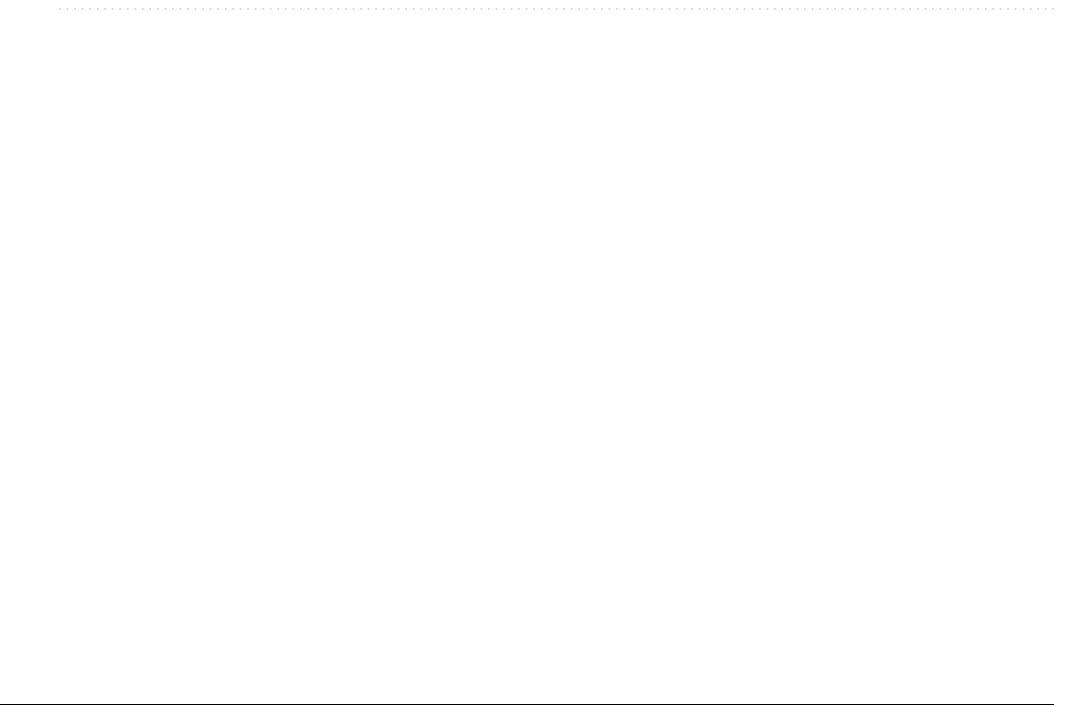
Figure 7. TEM images of ( a ) GO, ( b ) BSA-rGO and ( c , d ) Sr-BSA-rGO nanosheets. Black dots in the TEM images, were Sr